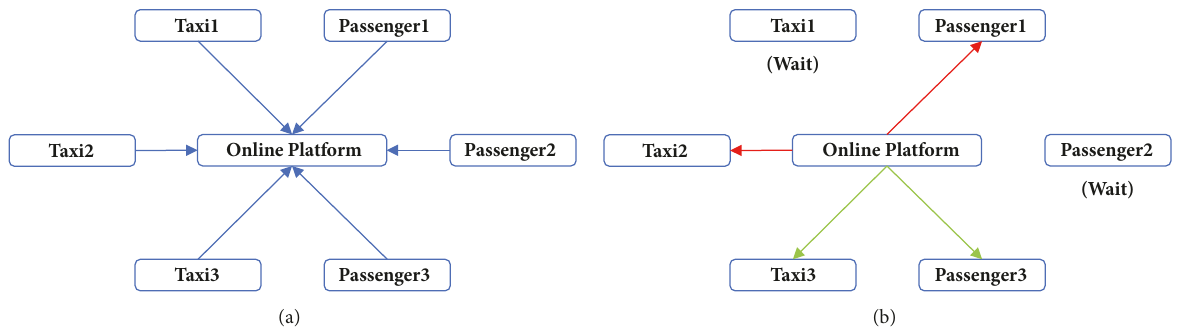
Figure 3: Information exchange of a hypothetical example. (a) Information flows in online platform. (b) Information flows out from online